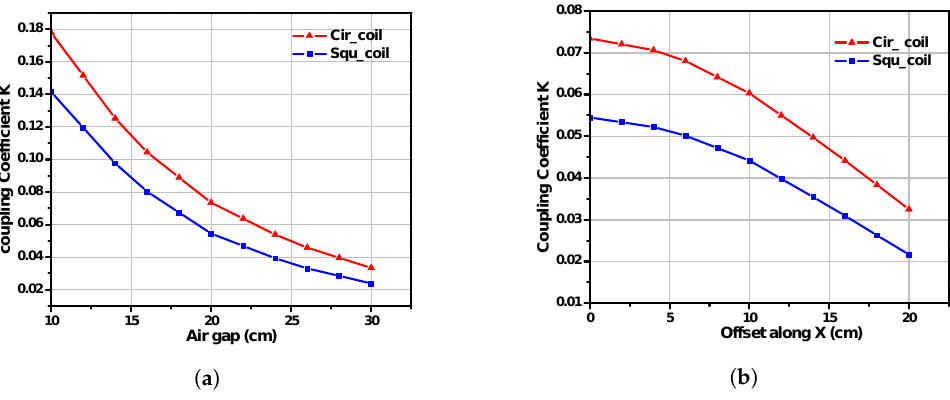
Figure 3. Circular and square coil geometries and k vs. ( a ) air gap and ( b ) misalignment.